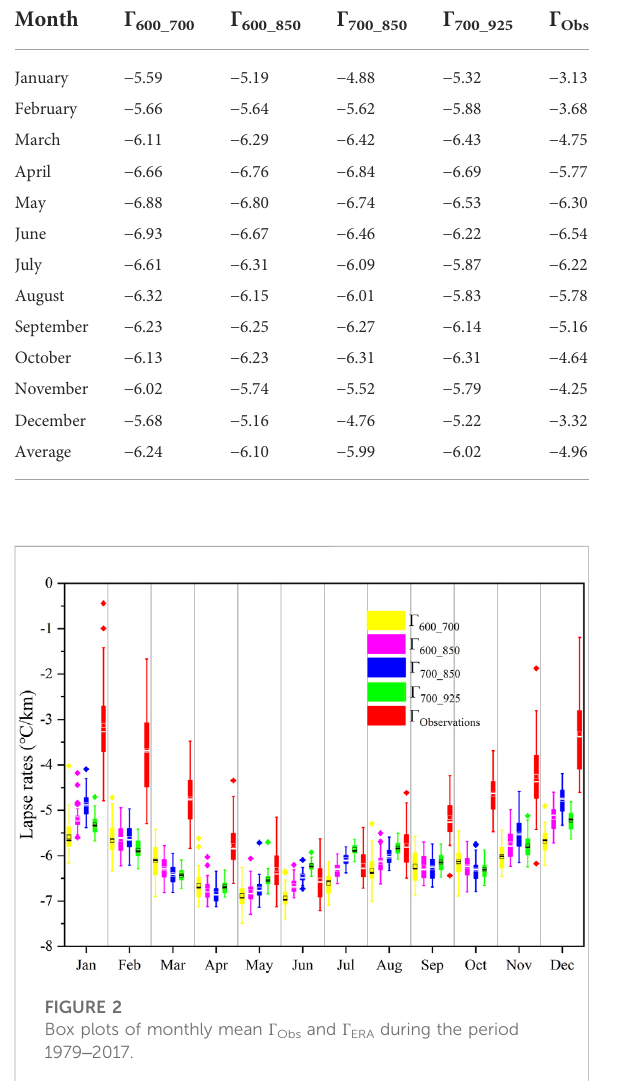
TABLE 3 Monthly lapse rates ( ° C/km) based on observations ( Γ Obs ) and ERA-Interim ( Γ 600_700 , Γ 600_850 , Γ 700_850 , and Γ 700_925 ) during the period 1979 – 2017.